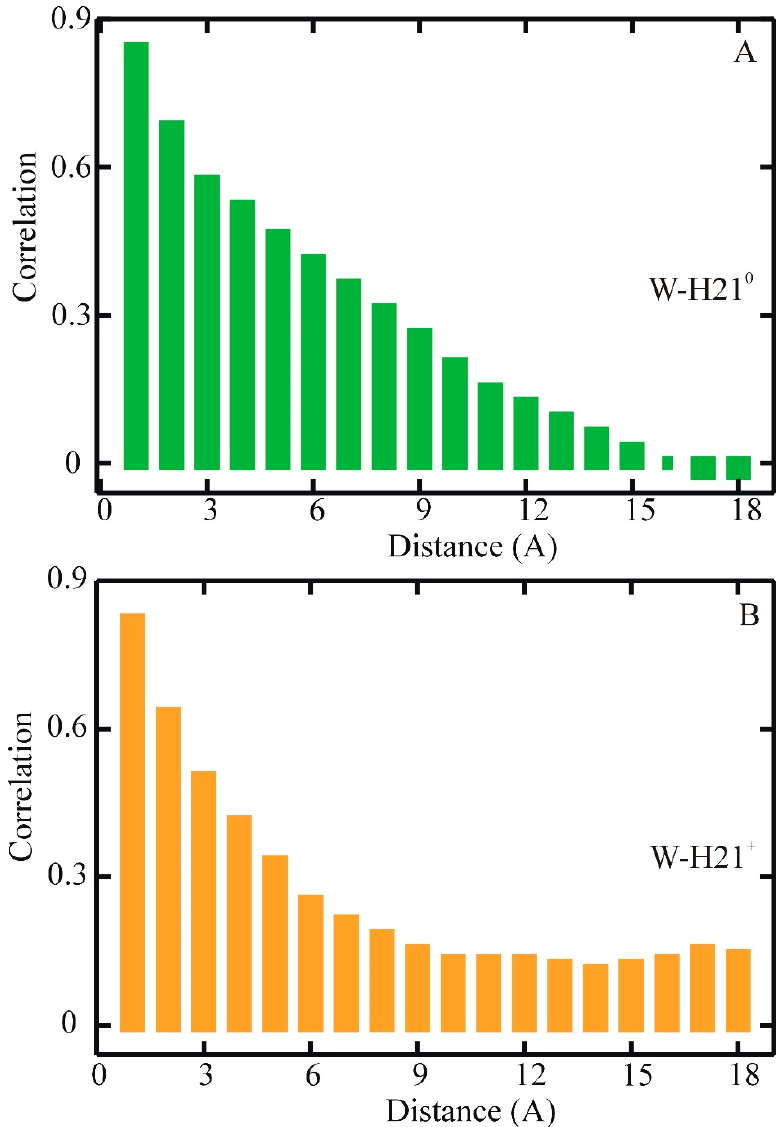
Figure 5. Correlation coefficients for intrachain fluctuations of hydrogen bonds as a function of the neighboring separation distance in sequence space. The displayed results are from the averaged data from hydrogen bonds, with the starting residues i differing by 1, 2, 3, …, 18 residues. ( A ) represents WH21 0 , and ( B ) is WH21 + [82].